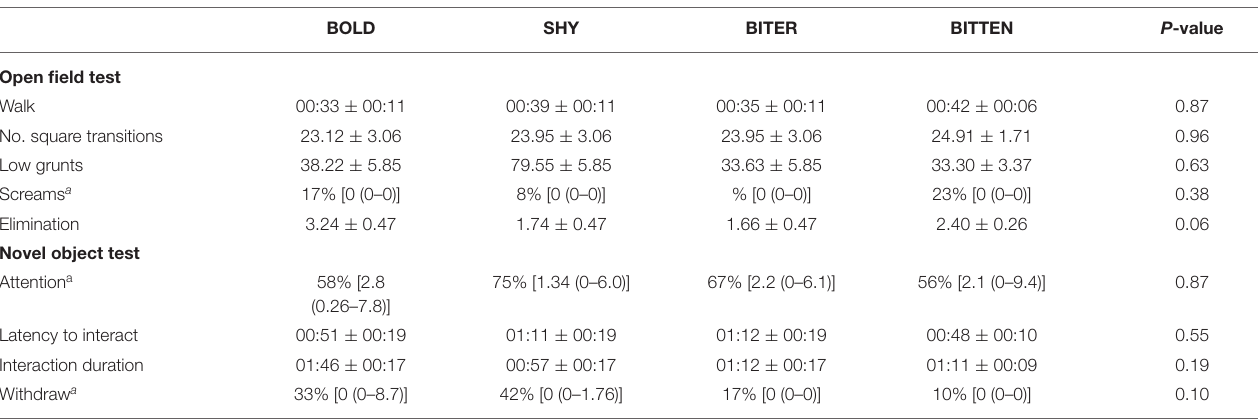
TABLE 4 | Results from the open field test and novel object test.